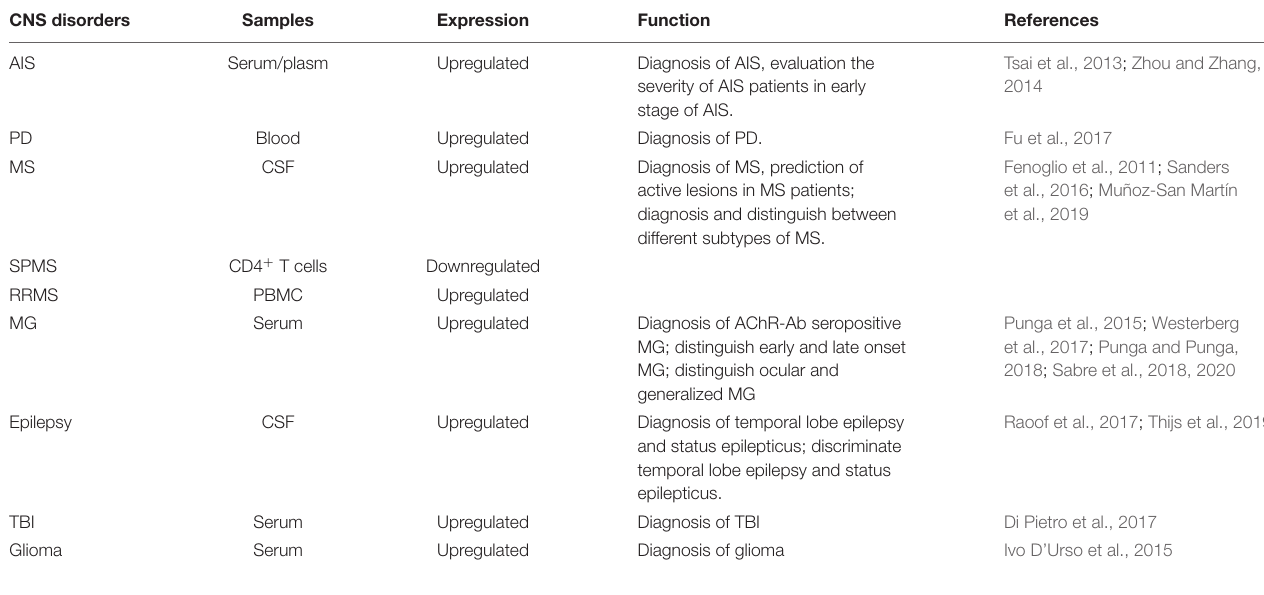
TABLE 2 | Circulating miR-21 as potential biomarkers in CNS